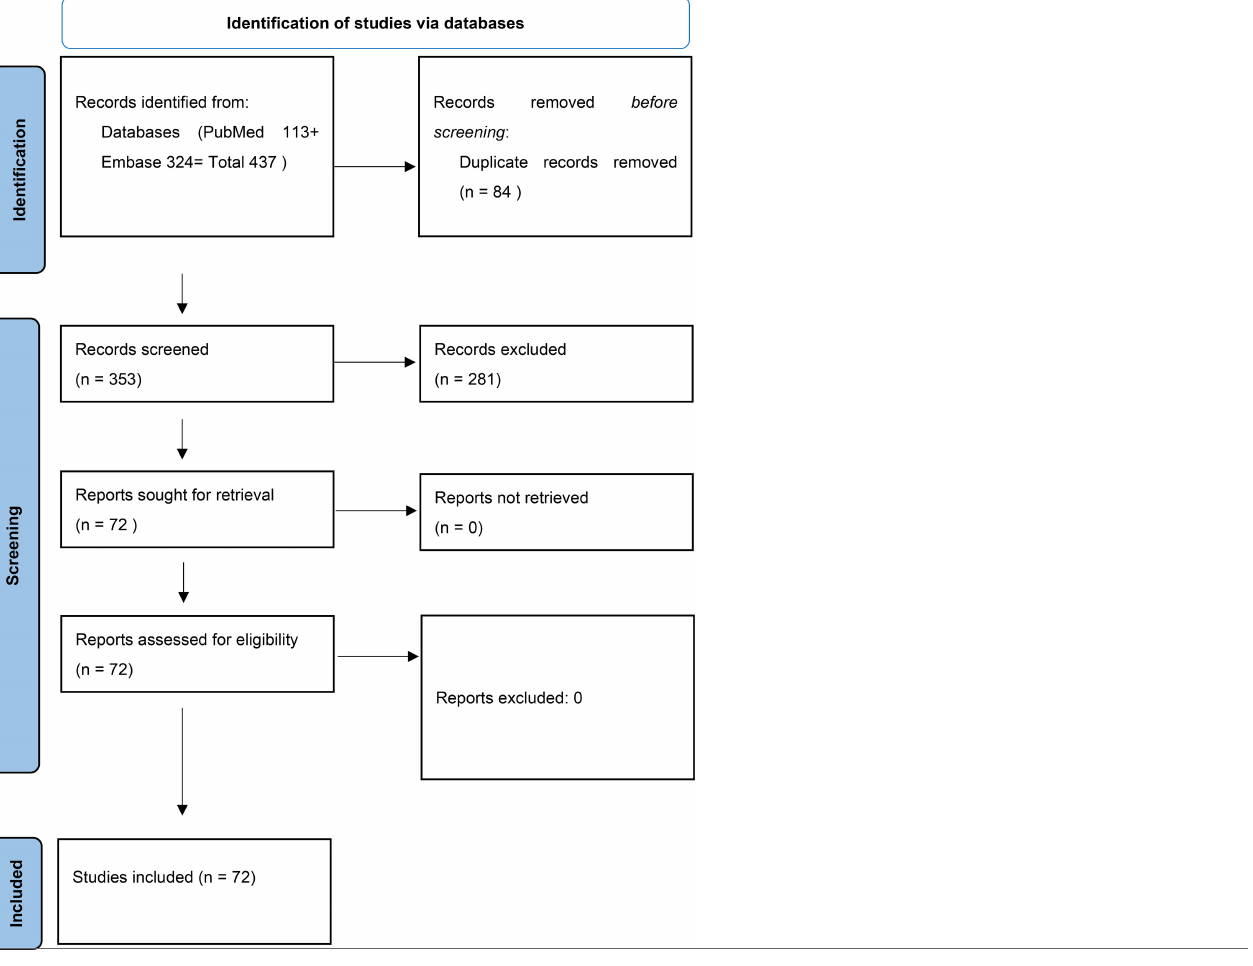
TABLE 2 | PRISMA fl ow diagram of